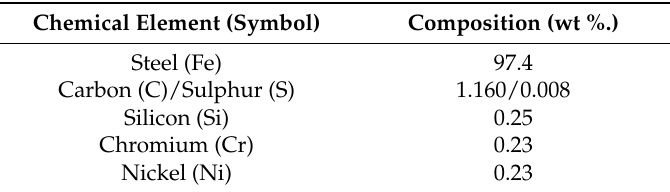
Figure 4. 7.62 mm API-BZ projectile and core. Table 1. Chemical composition of API-BZ steel nuance.